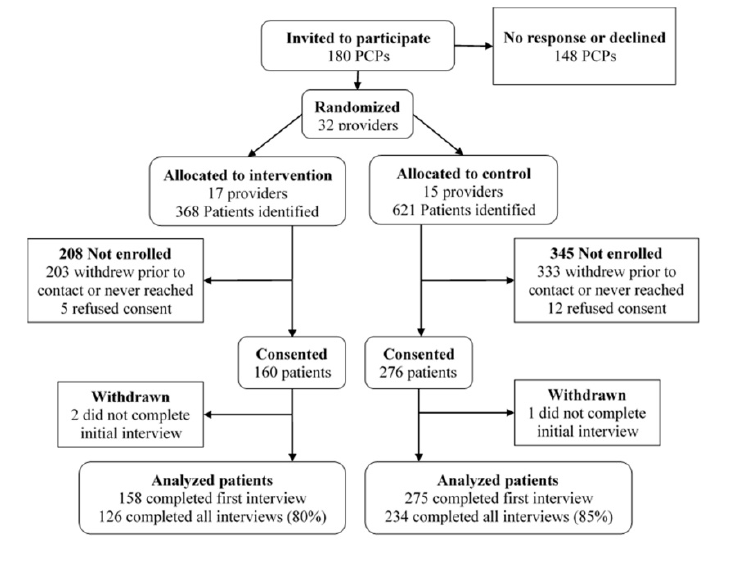
Figure 2 Flow of participants through stages of the randomized-cluster controlled